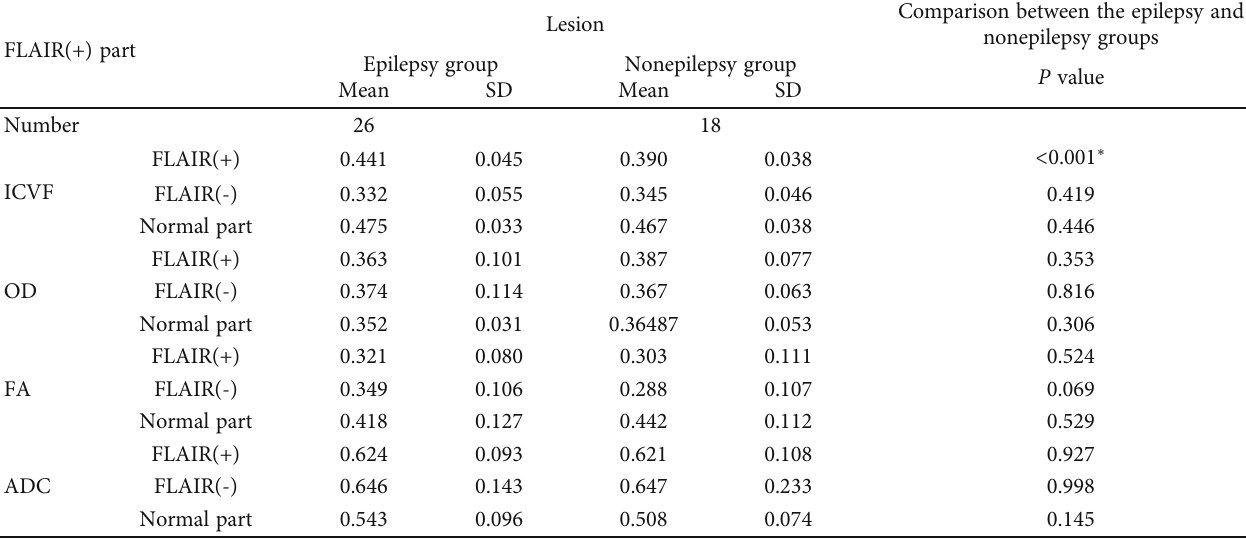
Table 3: NODDI parameter comparison of FLAIR hyperintense lesions in the epilepsy group and nonepilepsy group. FLAIR(+) part